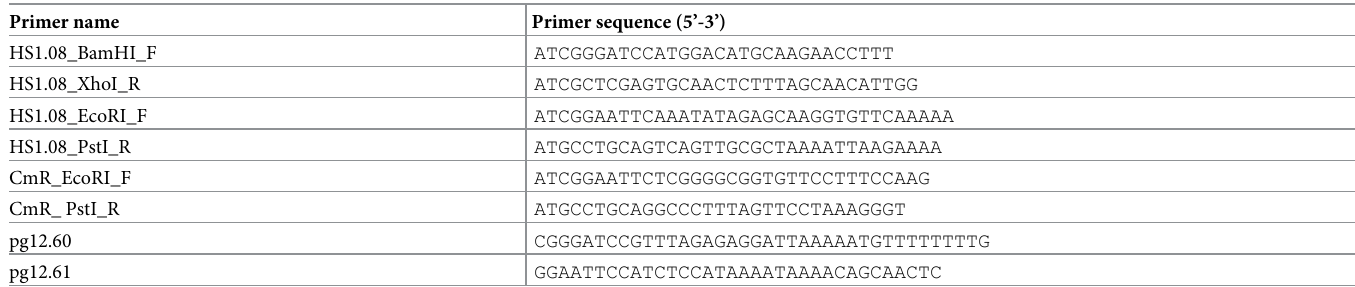
Table 2. Primers used in this